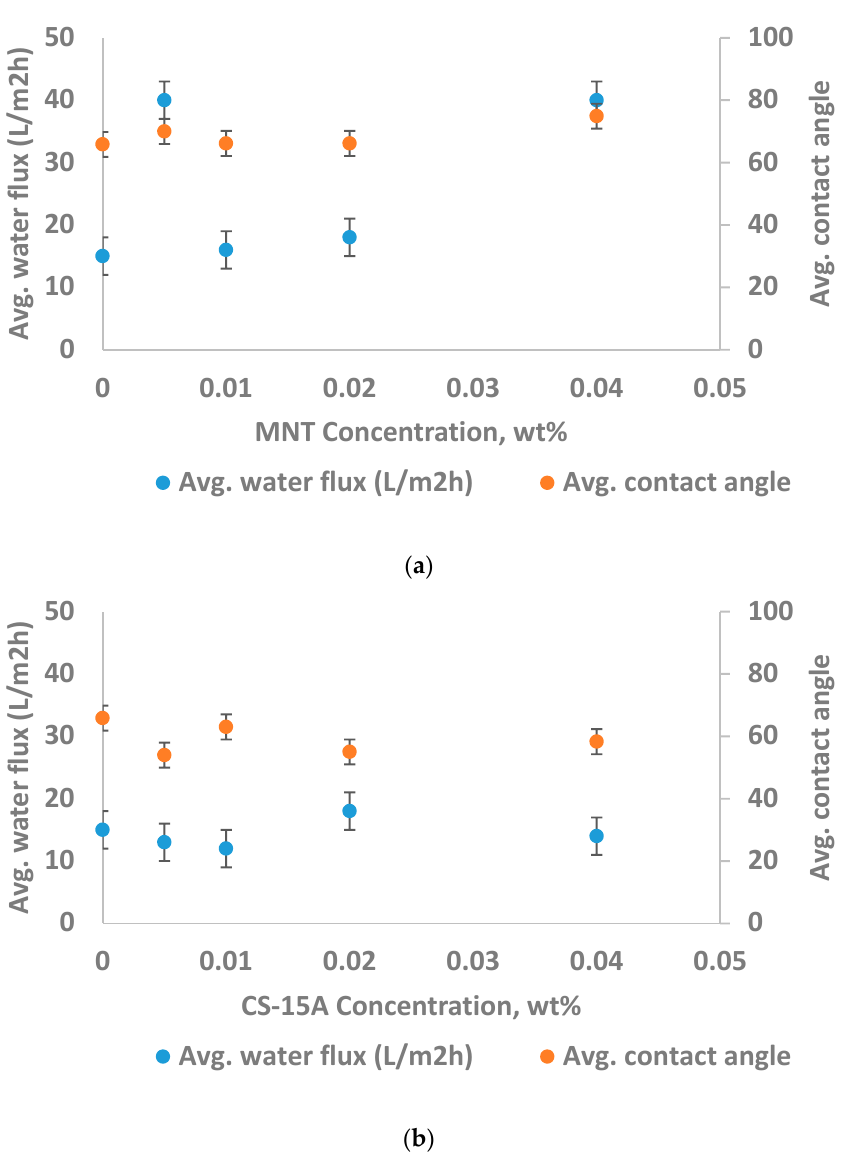
Figure 9. Impact of ( a ) montmorillonite (MNT) concentration and ( b ) cloisite-15A (CS-15A) loading on the performance of a membrane, as well as membrane hydrophilicity (the test was conducted at a feed temperature of 25 °C, a pressure of 40 bars, pH of 6, and a feed NaCl concentration of 2000 ppm).